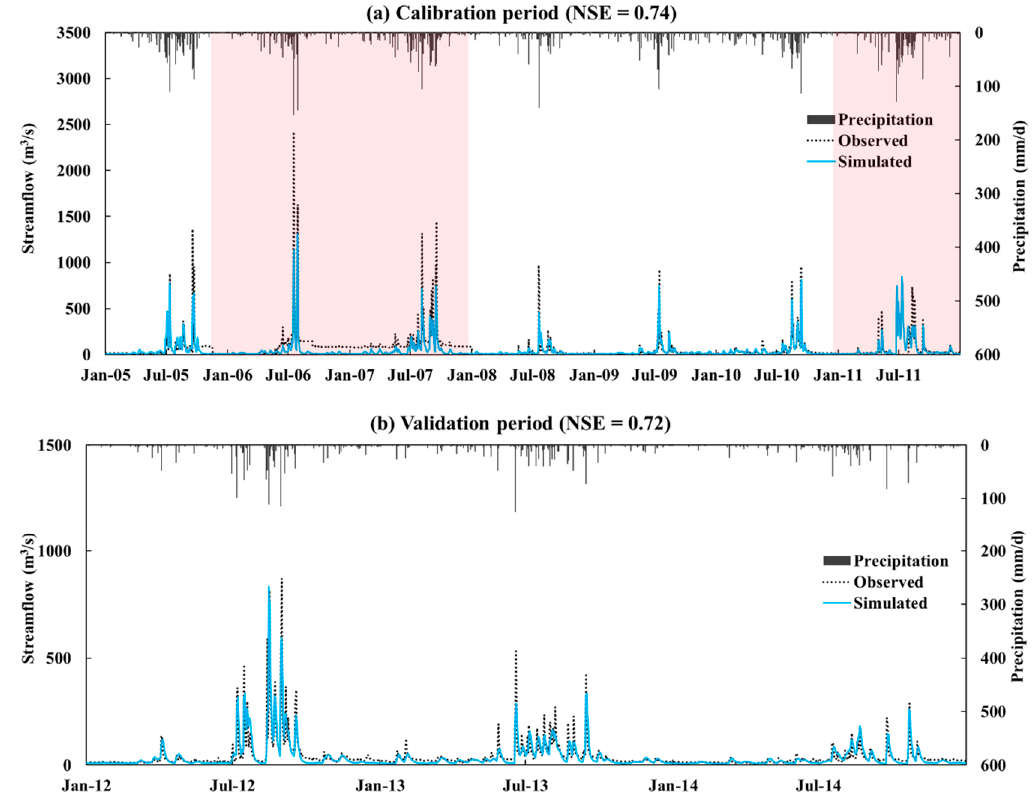
Figure 4. Comparison of the simulated and observed streamflow at the Hapgang stream gaging station during both the calibration and validation periods. Observed streamflow was incorrect due to rating curve errors during 2006, 2007 and 2011 (pink shading). Values during these periods were excluded when calculating the Nash–Sutcliffe efficiency (NSE) for the calibration period.